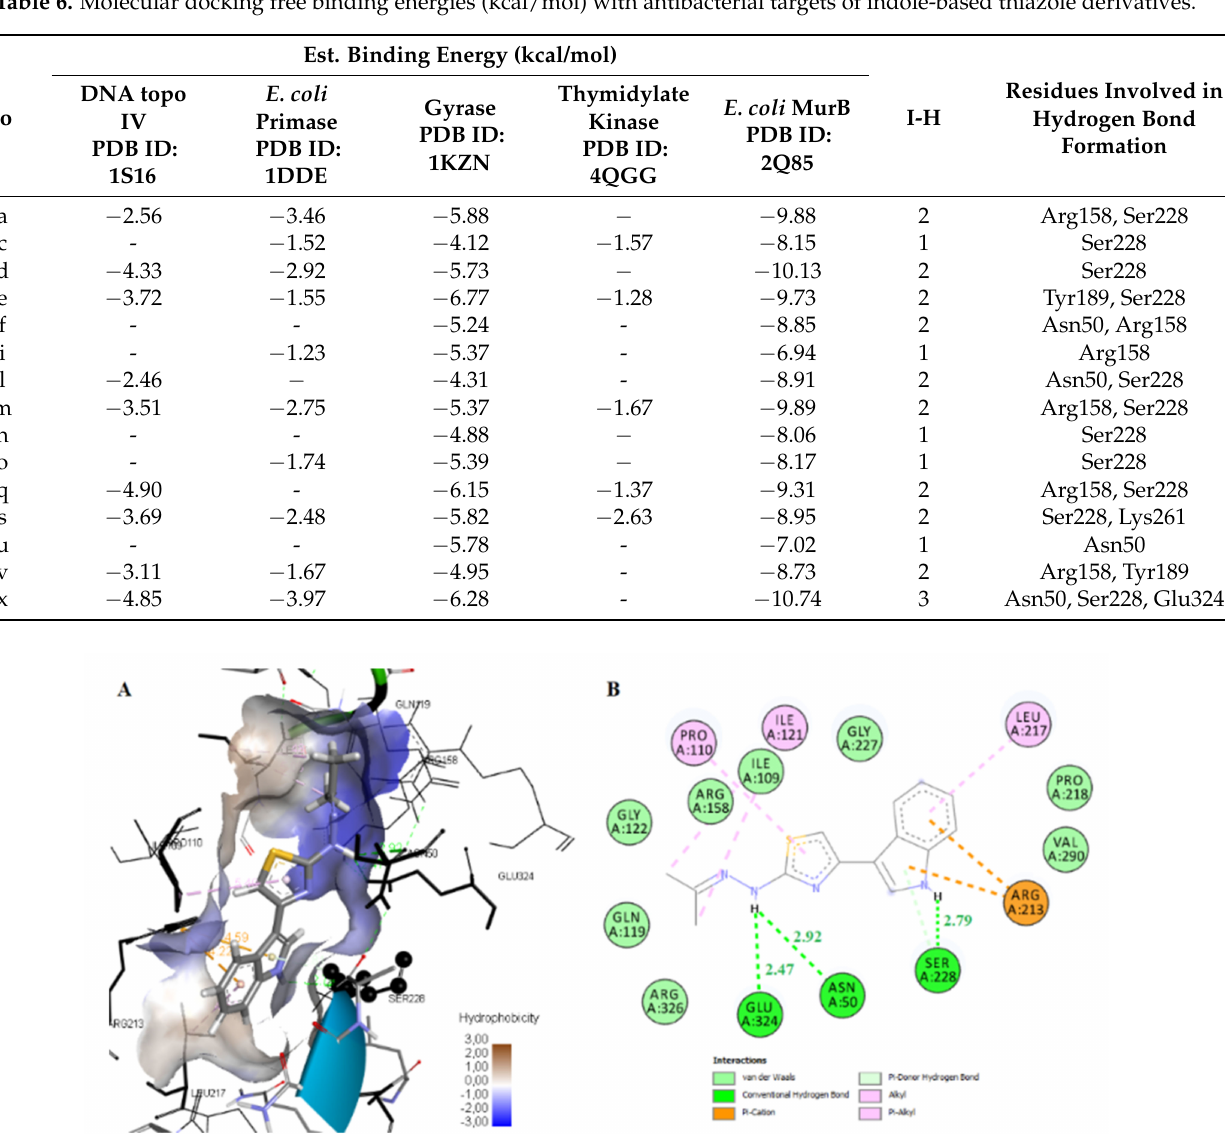
Table 6. Molecular docking free binding energies (kcal/mol) with antibacterial targets of indole-based thiazole derivatives.